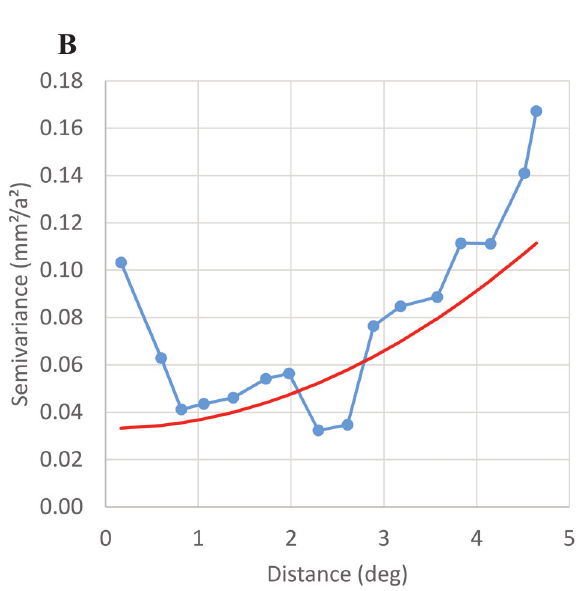
Fig. 7. The empirical (blue) and modelled (red) variograms in North ( A ), East ( B ) and Up ( C ) directions estimated for the residual 3D velocity components N, E, U of the 1st-order GRN points and CORS in Estonia. The number of lags is 15 in all variograms. Numbers near points in variogram (A) represent the number of